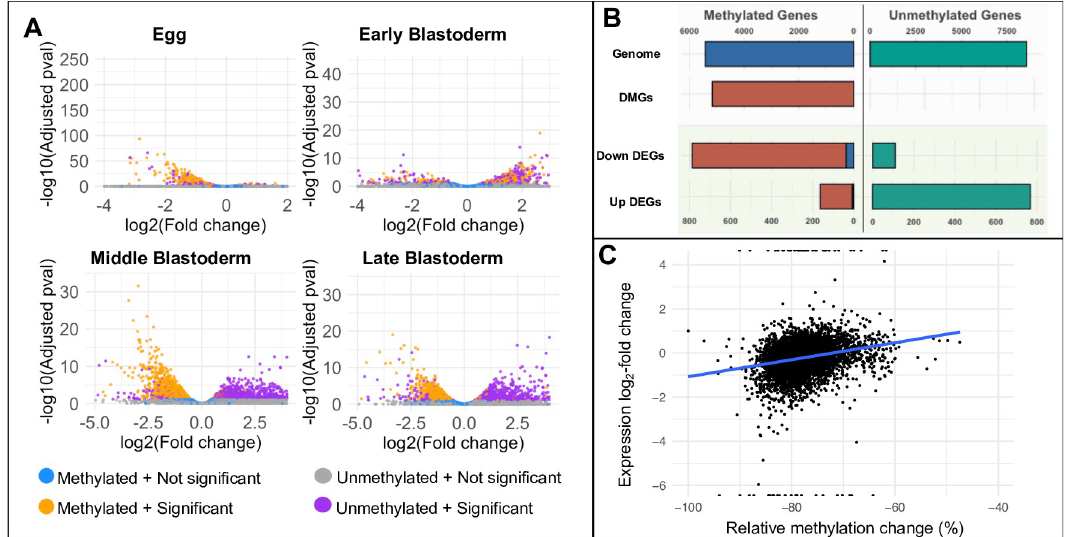
Fig 4. Gene expression of methylated and unmethylated genes in control and Nv-dnmt1a pRNAi N . vitripennis embryos. (A) Volcano plots showing differentially expressed genes between control and Nv-dnmt1a pRNAi in embryos of different developmental stages. X axis is log2 fold change in Nv-dnmt1a pRNAi samples relative to control samples. Y axis is log10 adjusted p-values. Golden dots are methylated, significantly differentially expressed (FDR-corrected p-value < 0.1). Purple dots are significant and DEGs that are unmethylated (FDR-corrected p-value < 0.1). Blue and grey are non-significant and represent methylated and unmethylated genes, respectively. (B) Distribution of methylated and unmethylated genes for all genes in the genome, differentially methylated genes (DMGs), down-regulated differentially expressed genes (Down DEGs), and up-regulated differentially expressed genes (Up DEGs). (C) The correlation between mean relative GBM change and mean relative expression change (calculated as log2-fold change) in the pRNAi samples compared to the control samples was positive and statistically significant (Spearman’s rank correlation coefficient = 0.37, p-value < 2.2e-16).